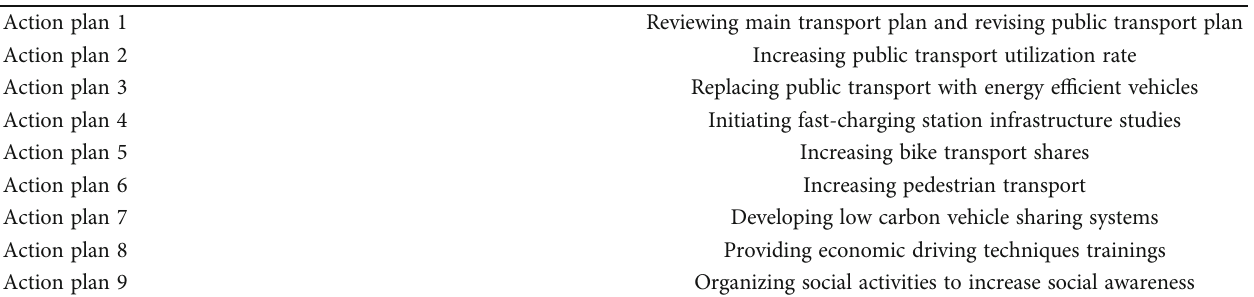
Figure 1: Growth rates of greenhouse gas emissions by transport units. Table 2: Transportation sector action plans for Sakarya